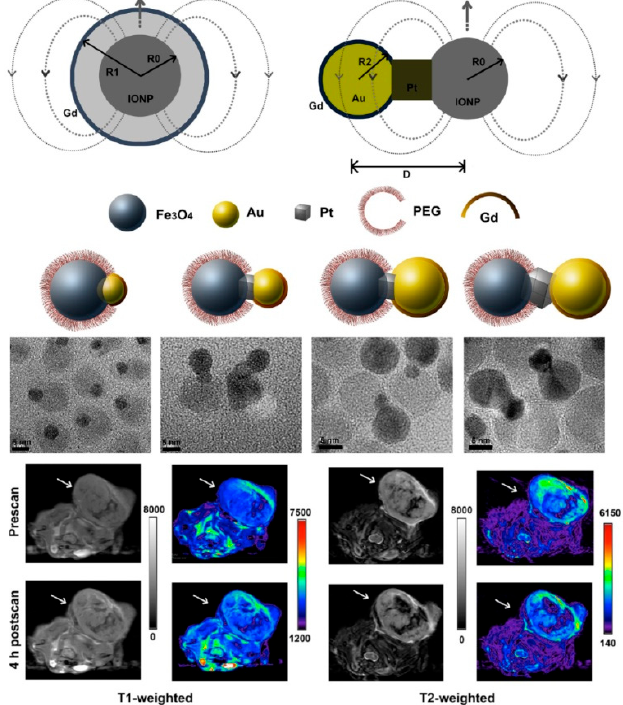
Figure 2. Design of a trimeric dumbbell for T 1 / T 2 MRI analysis. The coating of iron oxide NPs with Gd-chelates hampers the exploitation as T 1 imaging probe, due to the close proximity of the magnetite core. The presence of the Pt spacer between iron oxide and gold NPs allows increasing the distance between the two MR contrast agents (Gd-chelate anchored on gold domain) and to achieve an effective dual MR imaging. In the lower panel, MRI was performed before and 4 h after the injection of heterostructure. For each time point, gray scale and pseudo-colored images are reported. Adapted with permission from ACS NANO 2014 , 8 , 9884 – 9896 [47]. Copyright 2014 American